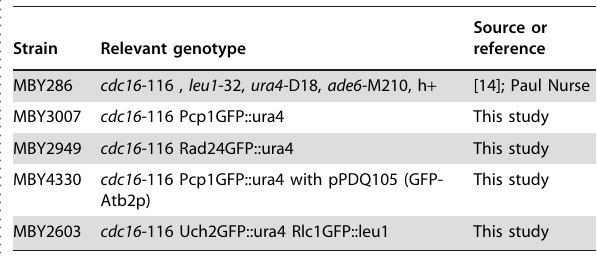
Table 1. Schizosaccharomyces pombe strains used in this study .. ... .... ... ... .... ... ... .... ... ... .... ... ... .... ... ... .... ... ... .... . Strain